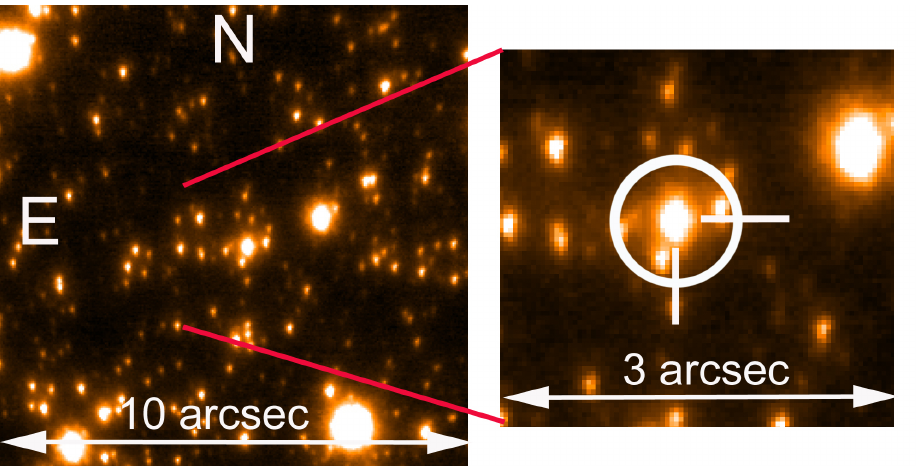
Figure 3. Keck II H-band observation of OGLE-2014-BLG-0124. The marked circle is 1 arcsec, showing that adaptive optics is essential for ground-based data to separate source and lens from unrelated blends. At the position of the source, we detect significant additional flux within 150 mas which is most likely the lens. The elongation seen on the image is consistent with the PSF shape of other nearby field stars